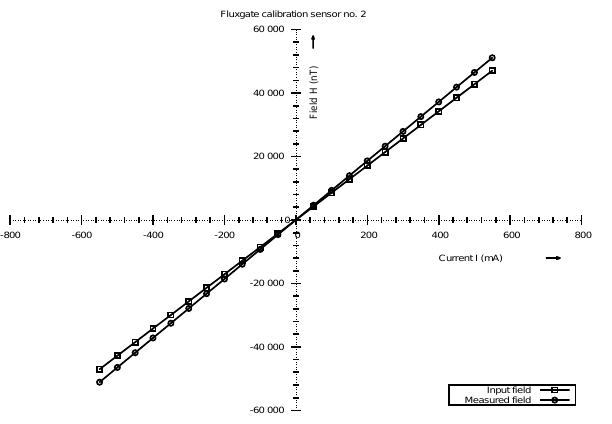
Figure 11. Fluxgate calibration using a z coil (sensor no. 1).